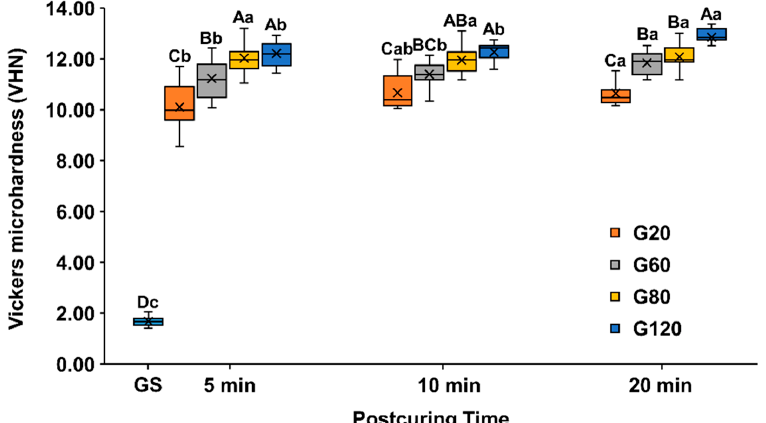
Figure 3. Vickers microhardness. Uppercase letters indicate significant differences by intensity within the same post ‐ curing time condition using Mann–Whitney with Bonferroni’s correction ( p < 0.005, A > B > C > D), and lowercase letters indicate statistical differences by post ‐ curing time within the same intensity conditions using Wilcoxon test with Bonferroni’s correction ( p < 0.0083, a > b > c > d). X mark means the average value of the data.